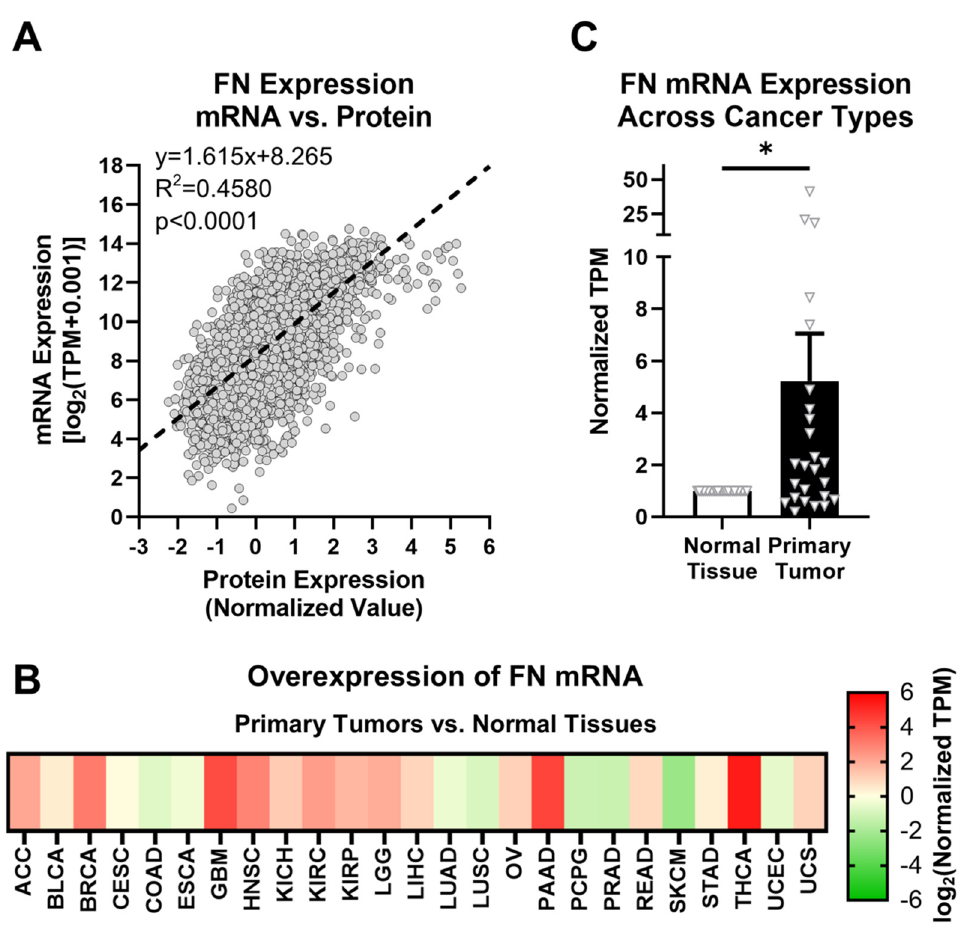
Figure 1. FN expression in primary tumors. ( A ) Correlation between FN protein and mRNA expression ( n = 6539). ( B ) Overexpression of FN mRNA in primary tumors versus normal tissues ( n = 25). Cancer types were excluded from analysis if the number of samples from either primary tumors or normal tissues was fewer than 10. ( C ) Average overexpression of FN mRNA in primary tissues versus normal tissues. Significance: *, p < 0.05.